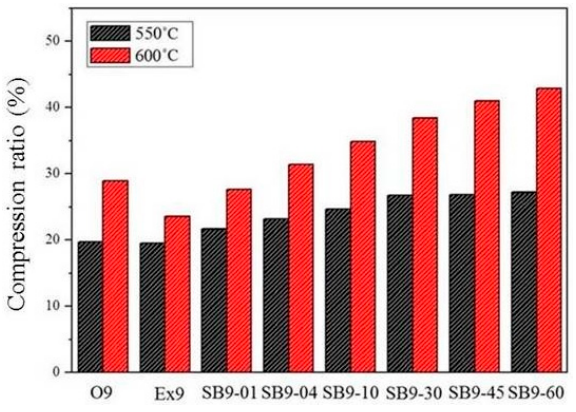
Figure 14. Compression ratios for samples.